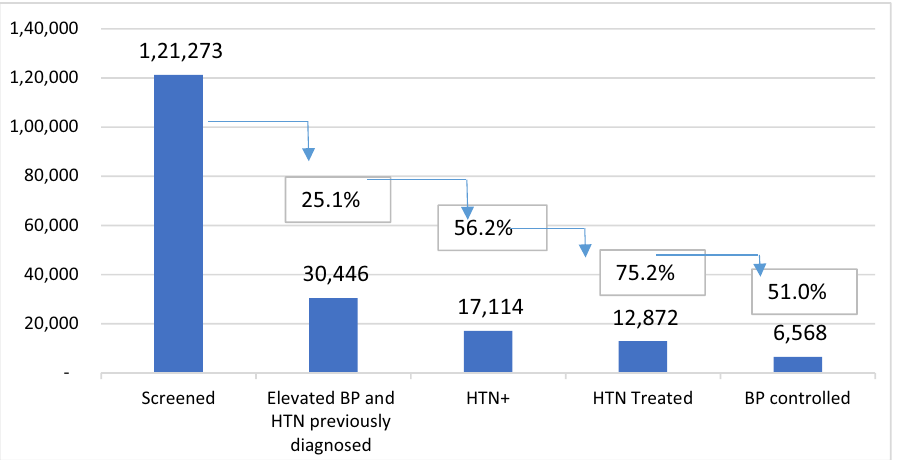
Figure 4. Proportion of Communities for Healthy Hearts clients screened, diagnosed, and treated for hypertension. Source : eTracker, PATH, 2016–2019.